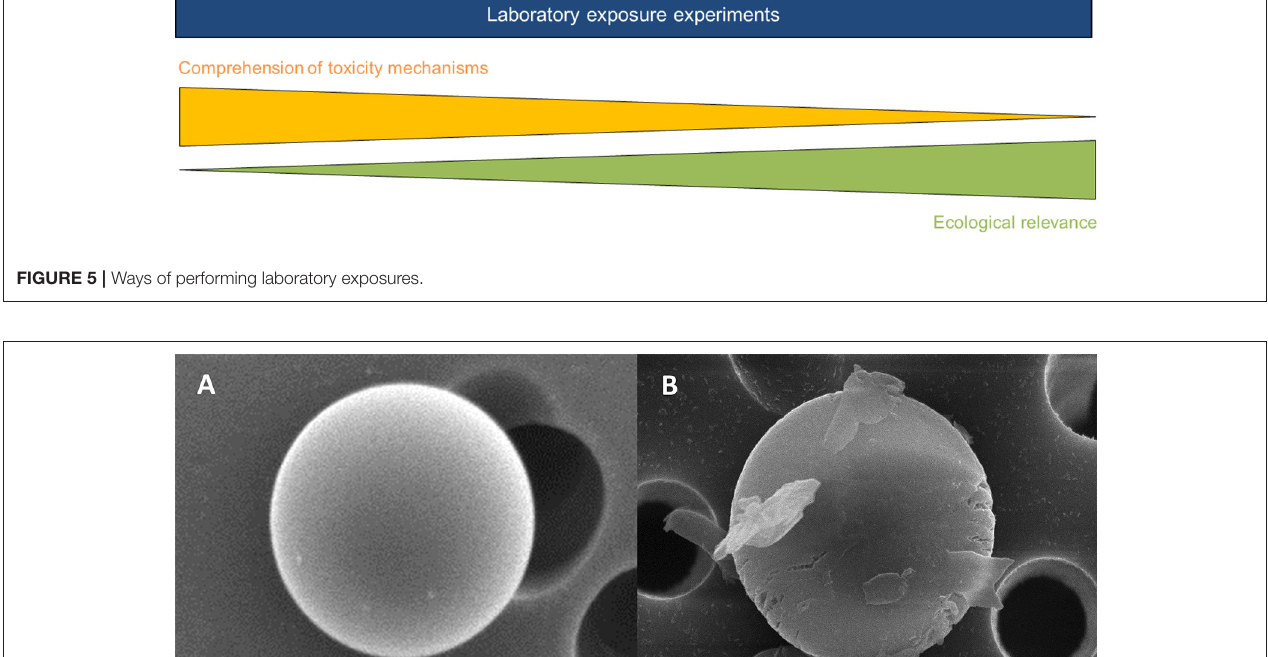
FIGURE 6 | Scanning electron microscopy observations of 5- µ m PMMA beads in pristine condition (A) and showing signs of erosion, presence of an organic corona and attached bacteria (B)